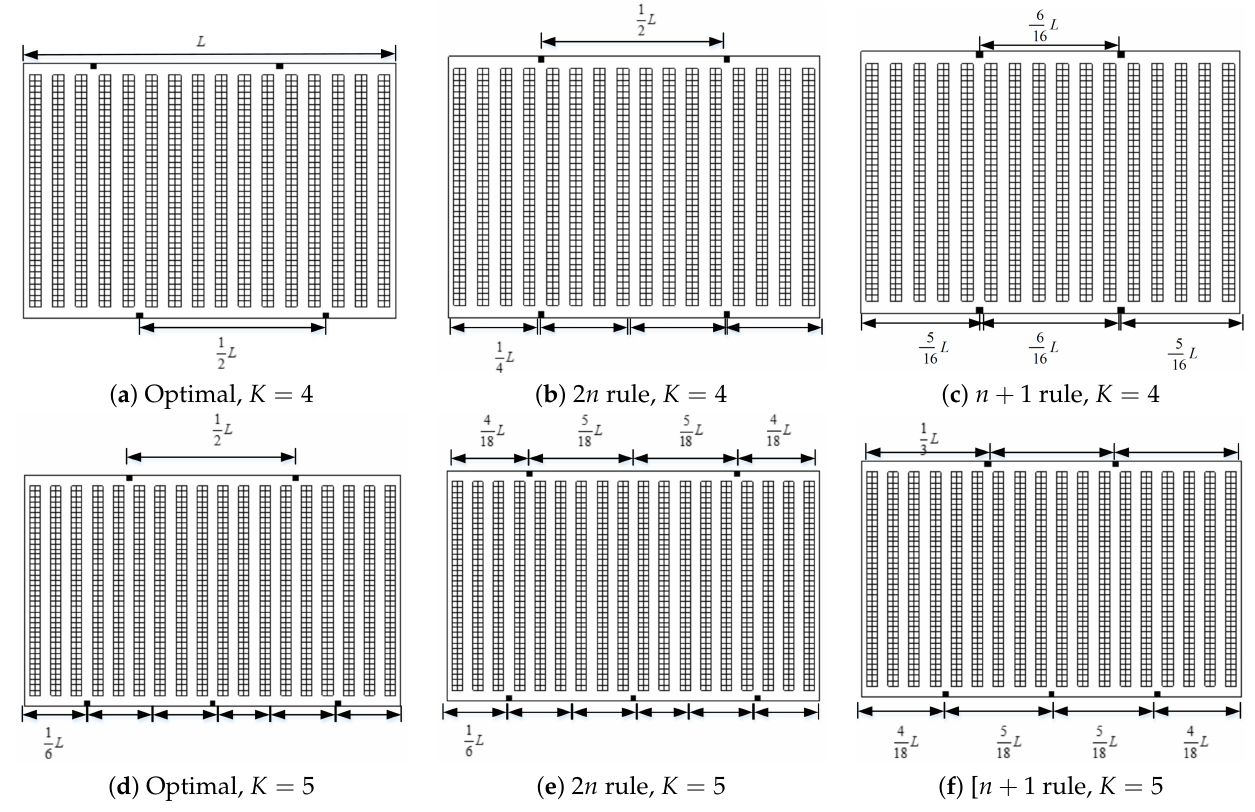
Figure 9. Workstation layout by optimization model and two simple rules ( N = 32, L = 40). Table 5. Evaluation of two rules for traditional layout with an odd number of workstations.